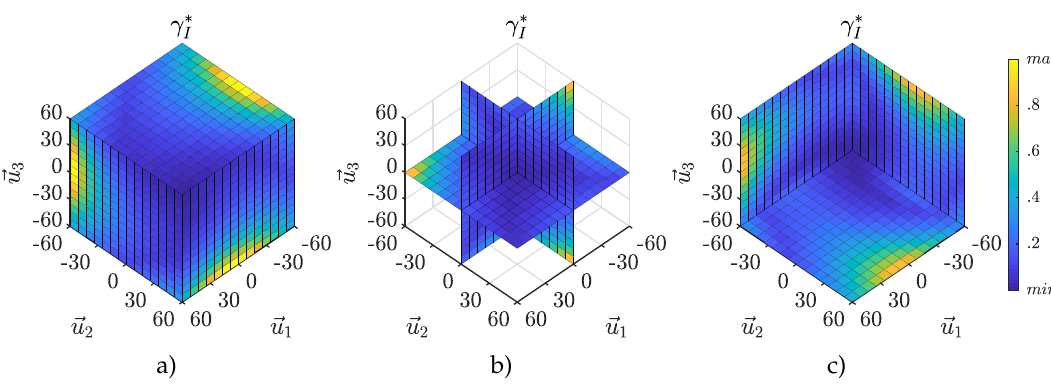
Figure 6. Volumetric isotropy distribution: ( a ) Outer surfaces, ( b ) middle surfaces, ( c ) inner